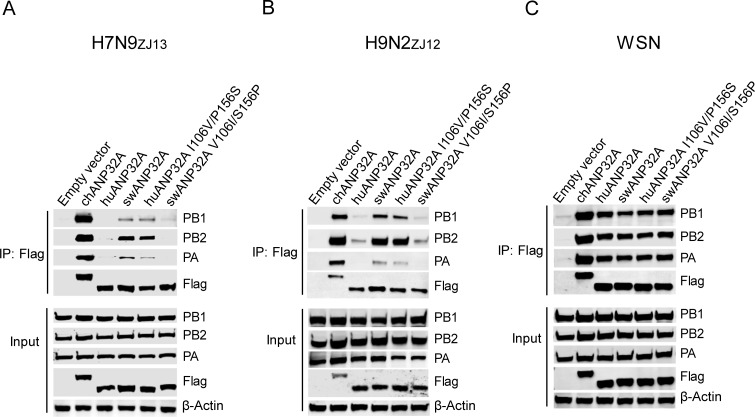
106V/156S sites of swANP32A are crucial for the interaction with avian polymerase trimeric complexes but not with mammalian polymerase.DKO cells were transfected with different ANP32A or mutants or empty vector (0.6μg), and plasmids carrying components of the viral polymerase (0.6μg PA, 1μg PB1, and 1μg PB2) from avian influenza virus H7N9ZJ13
(A), H9N2ZJ12
(B), or human influenza virus WSN (C). The cells were lysed at 24 h post-transfection. Co-IP was performed using Anti-FLAG M2 Magnetic Beads, followed by Western blotting to detect the ANP32A and viral proteins by using specific antibodies, PA antibody (NBP2-42874, NOVUS), PB1 antibody (NBP2-42877, NOVUS), PB2 antibody (NBP2-42879, NOVUS), Anti-Flag antibody (F1804, SIGMA).